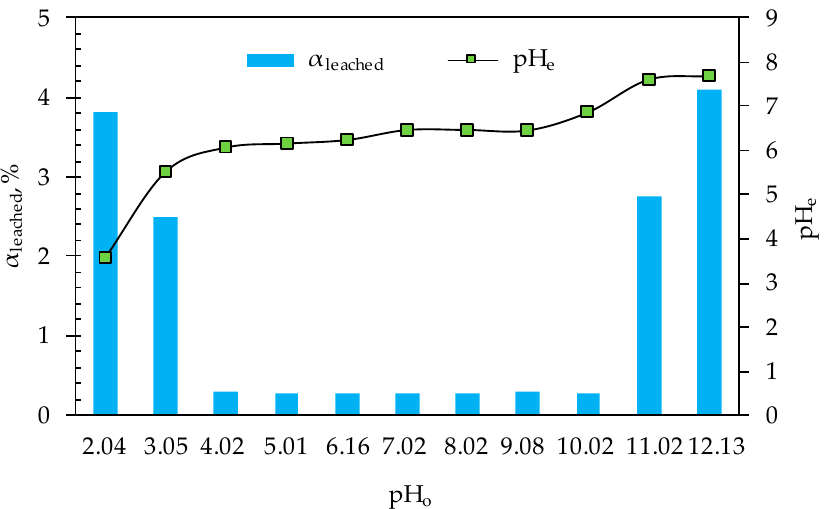
Figure 20. Percentage of leached Hg(II) from saturated SZHg and pH e as a function of ultrapure water at different pH o values.